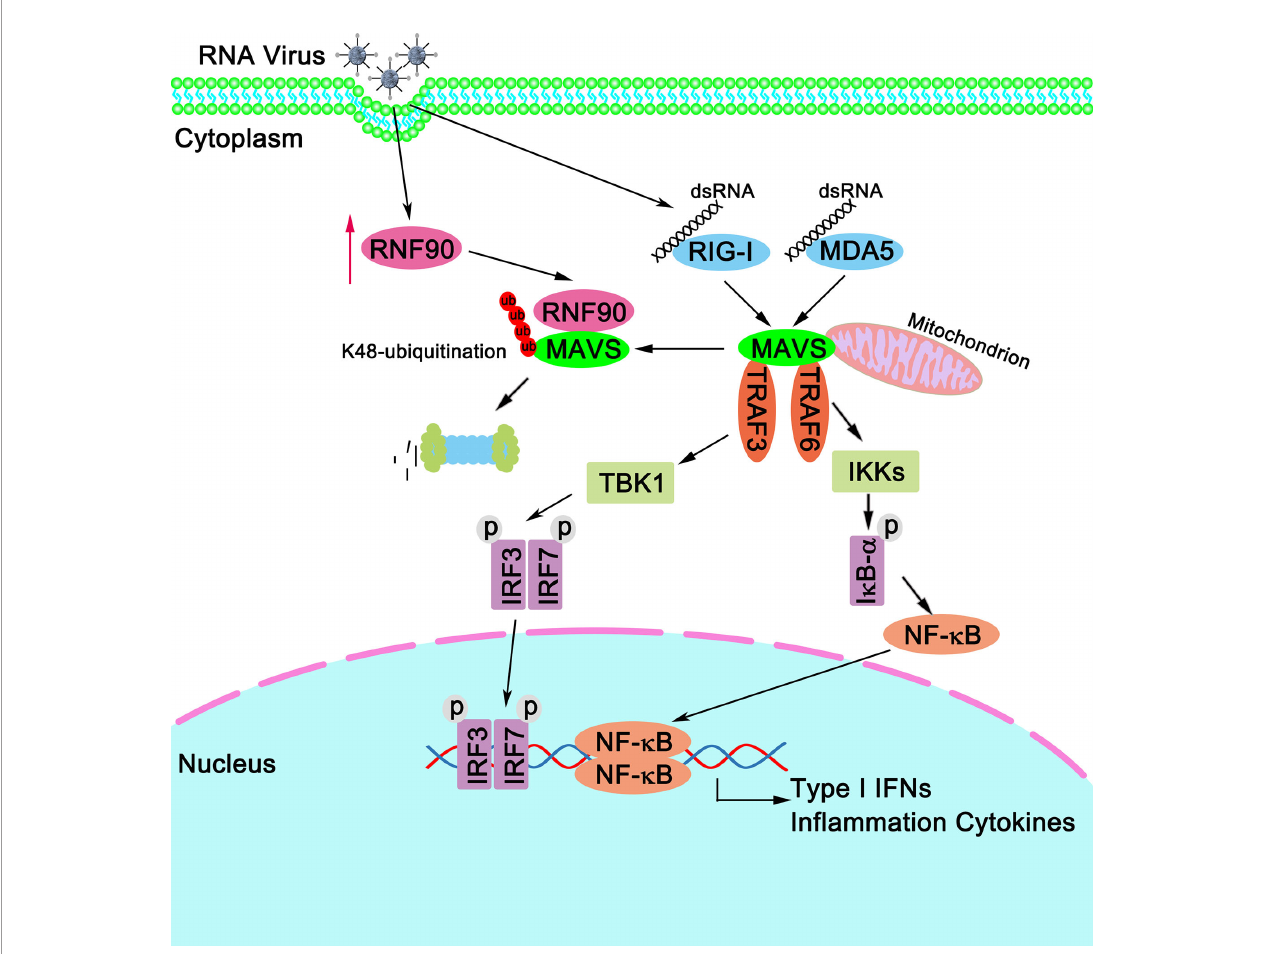
FIGURE 11 | A schematic model illustrating functional involvement of RNF90 in MAVS-mediated antiviral signaling. Upon RNA virus infection, RIG-I binds to viral dsRNA and activates MAVS. MAVS recruits TRAF3 and TRAF6 to activate type I IFN and in fl ammation cytokines production. Host protein RNF90, as identi fi ed in this study, ubiquitinates MAVS for degradation and tones down the responses to RNA virus infection, thereby contributing to the maintenance of balanced antiviral innate immune